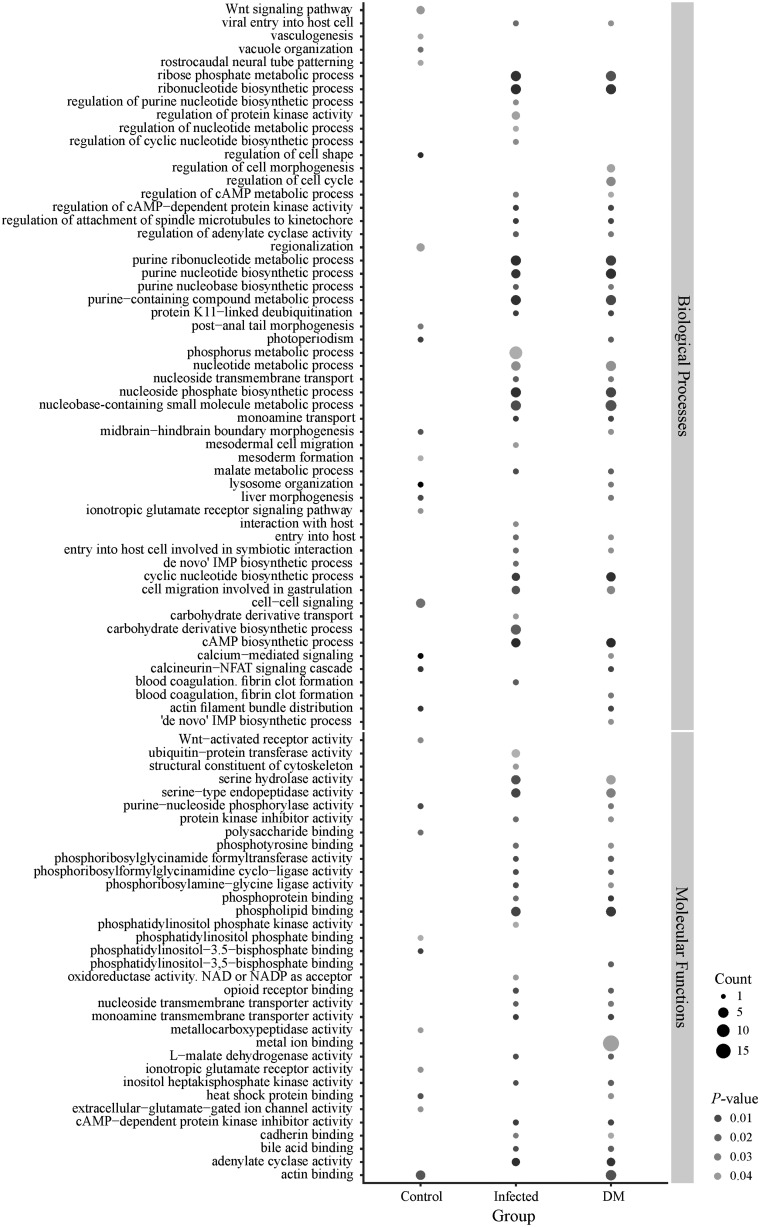
GO terms. BPs and MFs that are hypermethylated in control and infected fish, as well as GO terms for DMSs between the two groups. The size of the circle refers to the number of genes observed in the group that are associated with this term and the shading of the circle to the P value (darker circles refer to a lower P value). DM refers to differentially methylated genes.